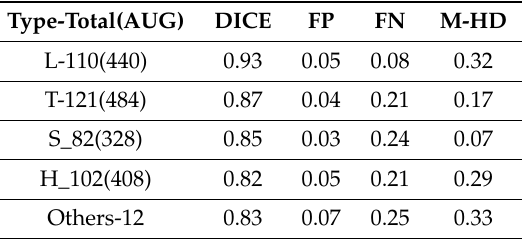
Table 1. Experimental quantitative